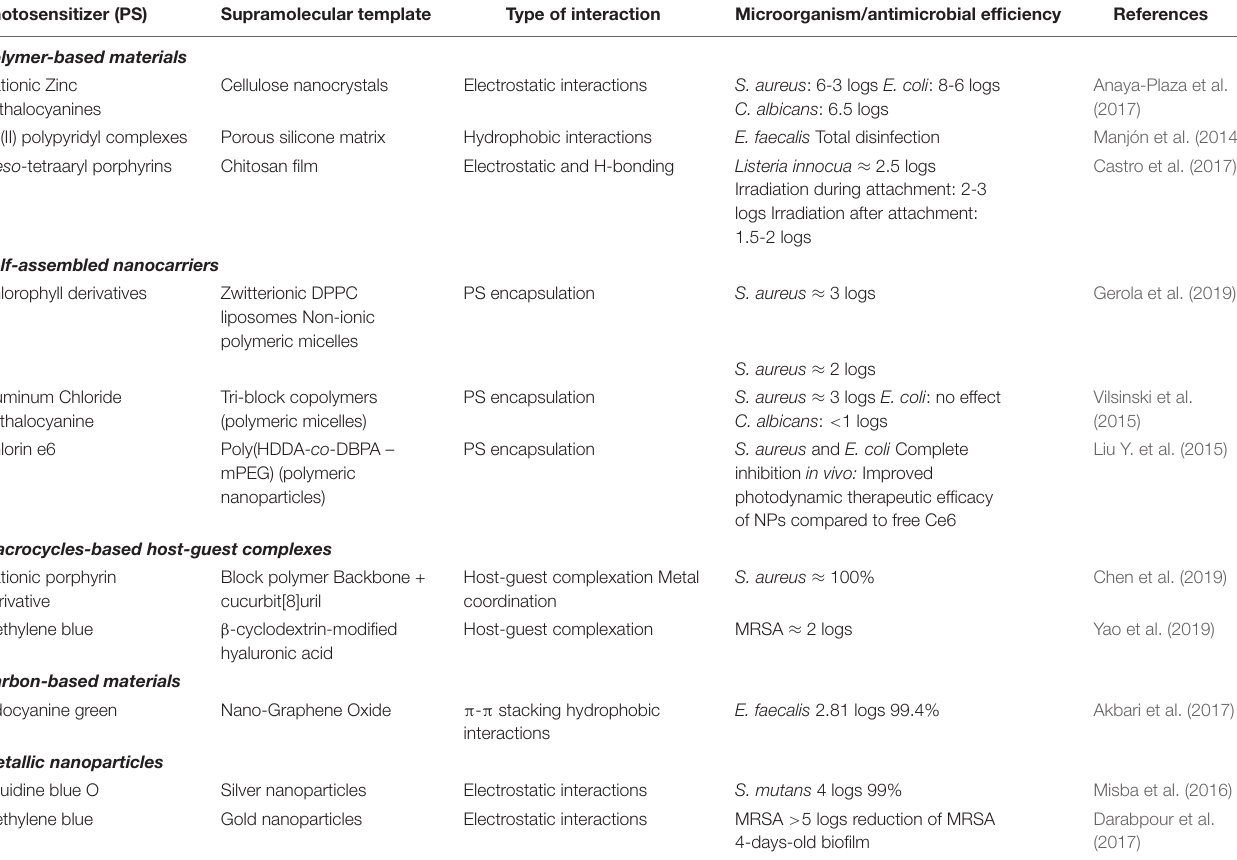
TABLE 1 | Summary of properties of selected examples of supramolecular photosensitizers (SPS) used in antimicrobial photodynamic therapy (aPDT). Photosensitizer